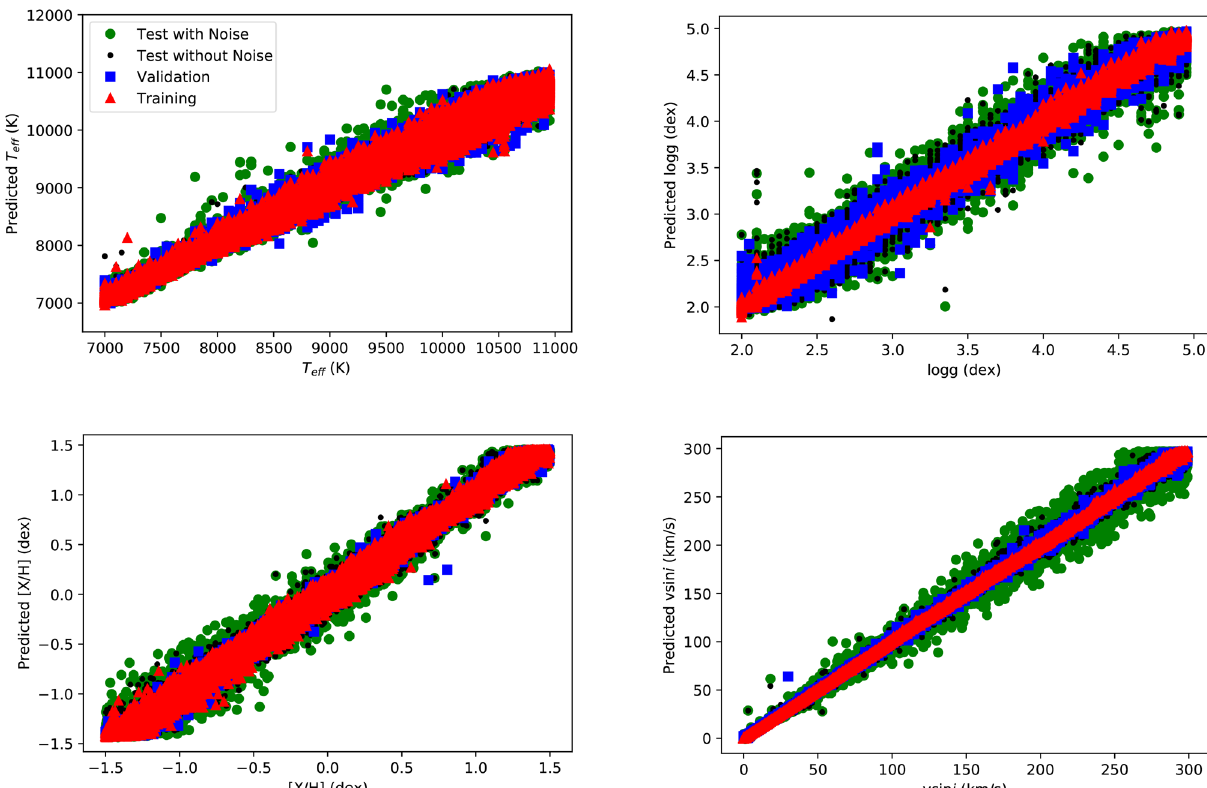
Figure 10: Predicted stellar parameters using the optimal CNN con fi gurations for T eff , g log , v i sin e for the training, validation, and test databases as well as for the noise added